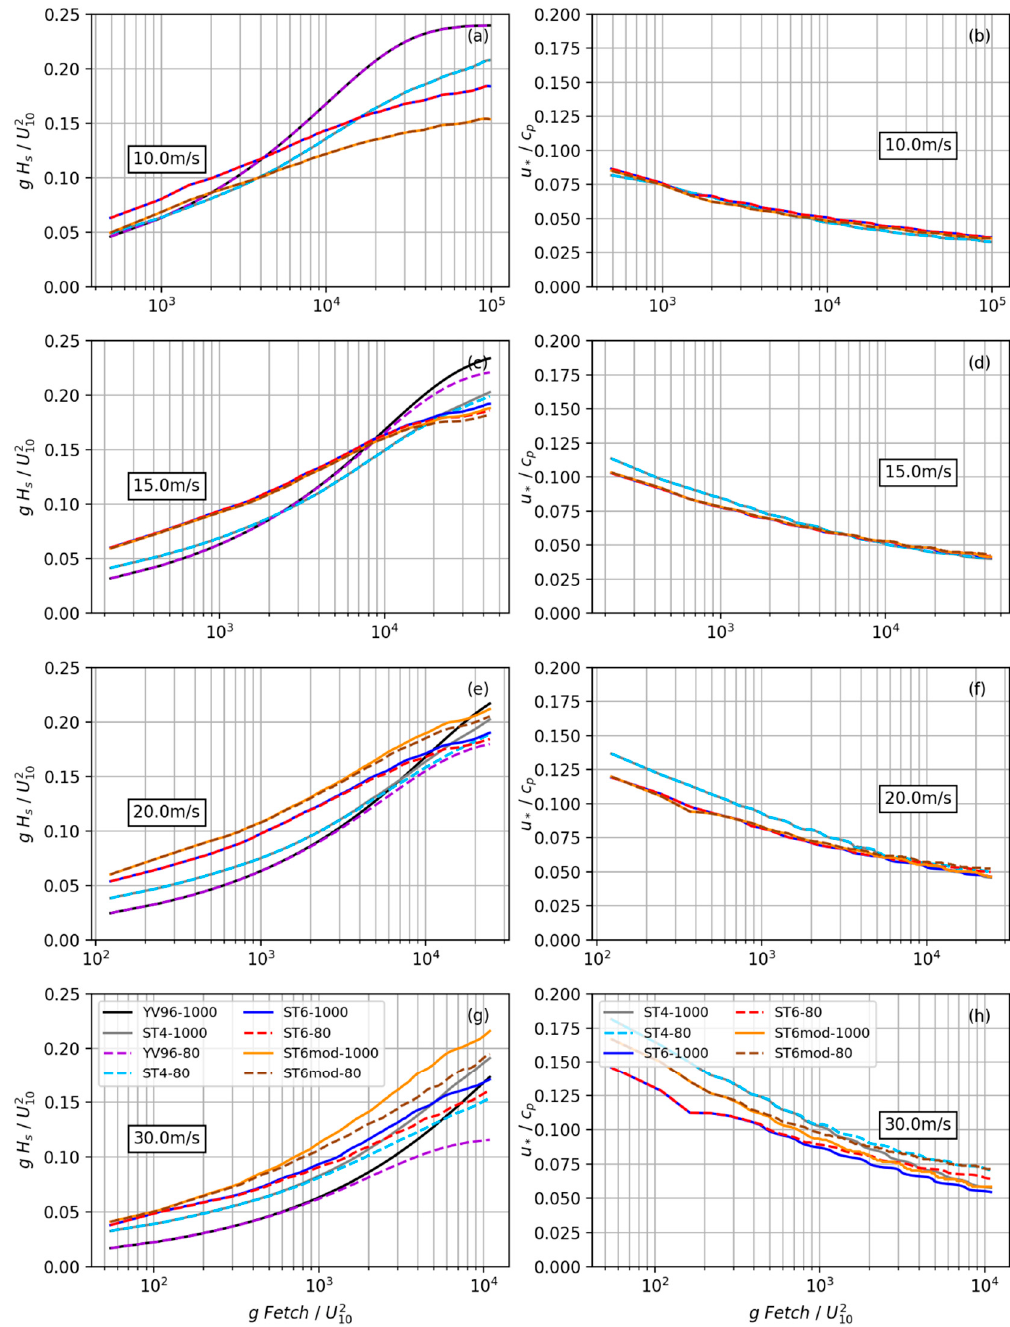
Figure 4. ( a , c , e , g ) Dimensionless wave growth and ( b , d , f , h ) inverse wave age as a function of dimensionless fetch for constant winds from 10 to 30 ms − 1 for different model configurations. Fetch limited growth and inverse wave age evolution curves include deep water and 80 m depth relationships for ST4 (ST4-1000 and ST4-80), ST6 (ST6-1000 and ST6-80) and ST6 with a modification on the drag coefficient as per Edson et al. [23] (ST6mod-1000 and ST6mod-80). The theoretical curve of Young and Verhagen [88] is presented in the fetch limited growth representation (YV96-1000 and YV96-80). Results for the different configurations correspond to 48 h model runs using a 5 km resolution grid.